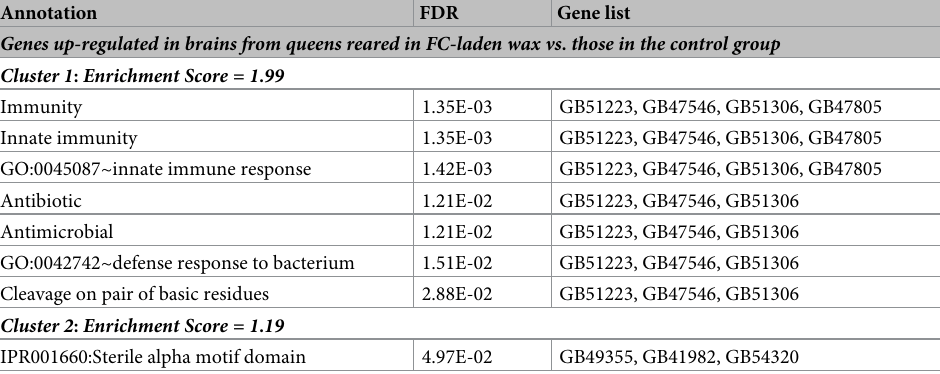
Table 4. Cluster analysis of differentially expressed genes in brain tissue from queens reared in wax containing a mix of tau -fluvalinate and coumaphos ("FC") compared to those reared in untreated (control) wax, using the online tool D.A.V.I.D. (Huang et al. 2009).